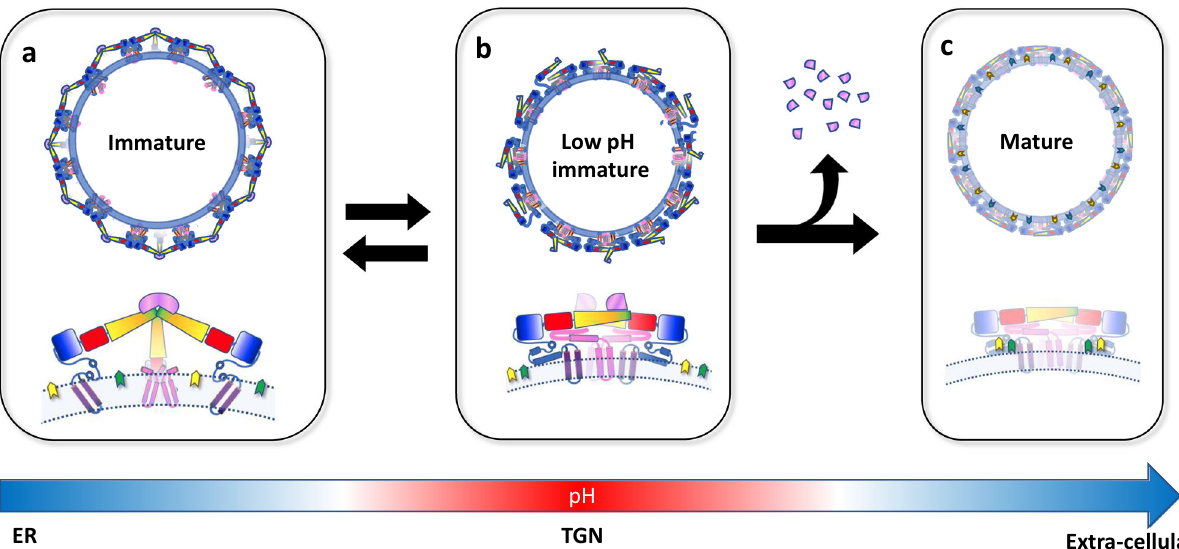
Fig. 10 Model of the lipid ligands' role in the fl avivirus virion. Cartoon representations of the virion in its a immature, b low-pH immature and c mature forms. The colour scheme is the same as Fig. 3 with the pr domain shown in pink like the rest of prM. The membrane is shown in blue. A blue – white – red gradient indicates acidi fi cation as the particle traf fi cs through the secretory pathway from the endoplasmic reticulum (ER) to the trans-Golgi network (TGN) and a return to neutral pH upon secretion. The low-pH immature particle is shown with an irregular surface since it is able to breathe and potentially revert to the immature particle if acidi fi cation is reversed. Once pr is cleaved and pocket factors are acquired, the particle is irreversibly converted to the mature